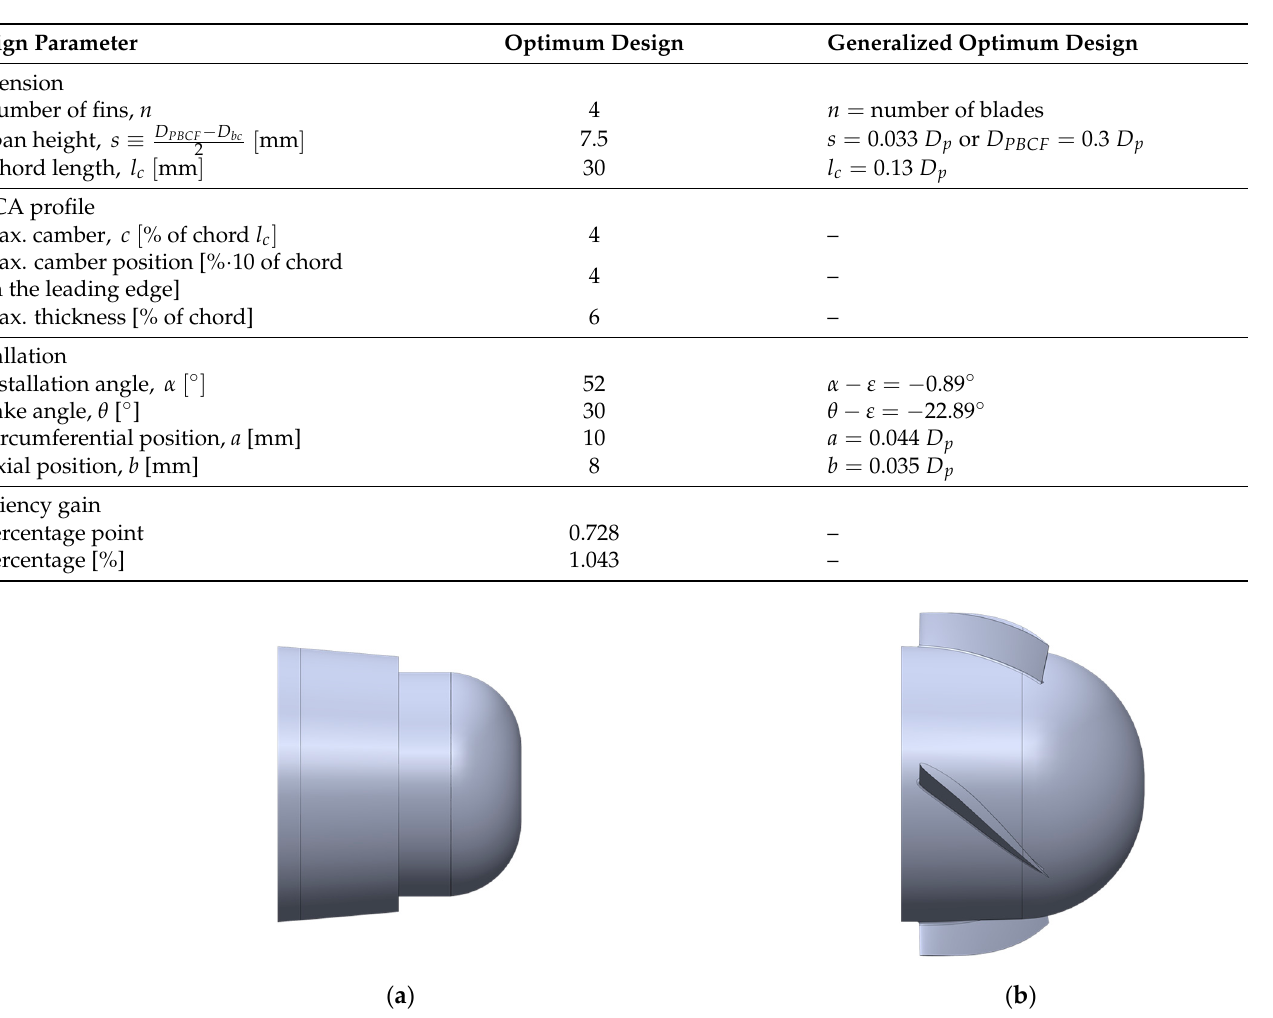
Table 7. The optimum PBCF design for the model-scale propeller ( D p = 226 mm, ε = 52.89 ◦ ,